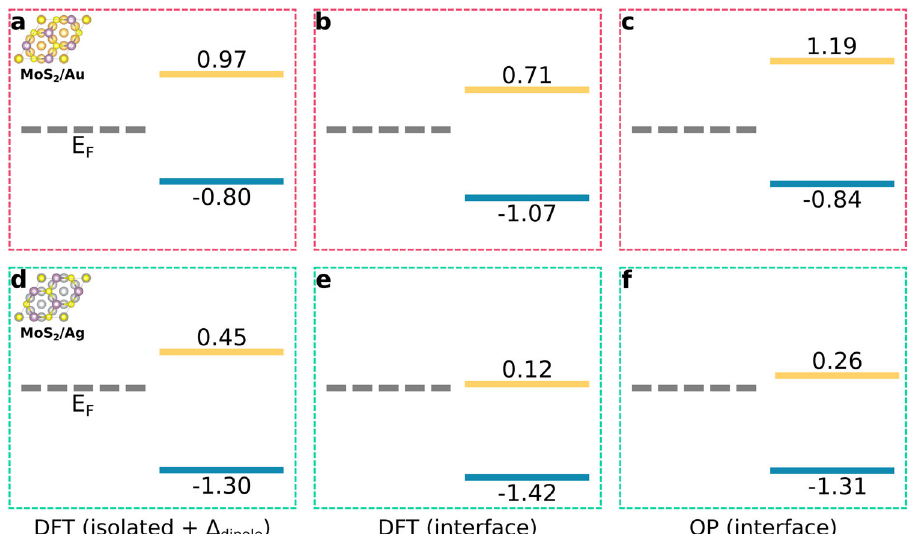
Fig. 2 Schematic of the energy level alignment (ELA) for pristine TMDC/metal junctions. Schematics are shown for ( a , b , c ) MoS 2 /Au and ( d , e , f ) MoS 2 /Ag. a , d show the ELA obtained by the alignment of the isolated materials, taking into account the calculated dipole correction ( Δ dipole ). b , e show the DFT ELA at the interfaces. c , f show the GW quasiparticle (QP) ELA at the interfaces. The valence band maximum and conduction band minimum levels are indicated by blue and yellow lines, respectively. Energies are given in eV, referenced to the Fermi level in each case (dashed grey lines). Atomic structures are shown as insets: Au (gold); Ag (silver); Mo (purple); S